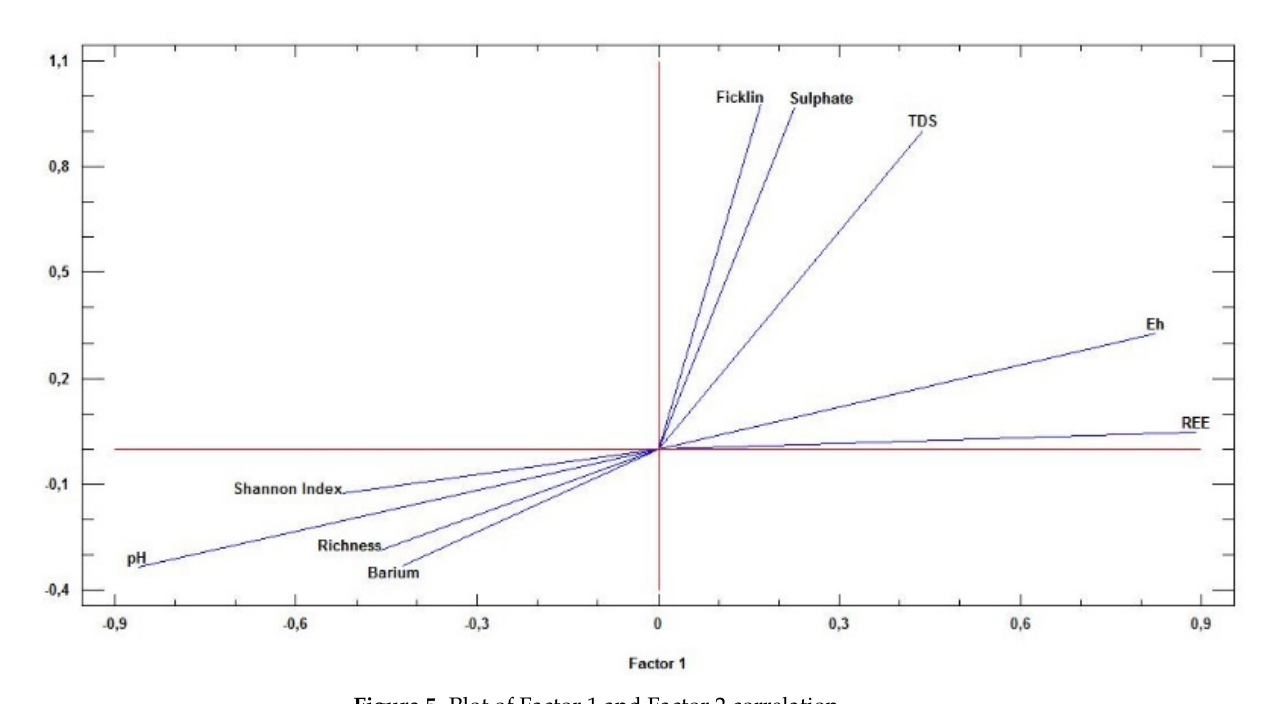
Figure 5. Plot of Factor 1 and Factor 2 correlation. Table 2. Factor